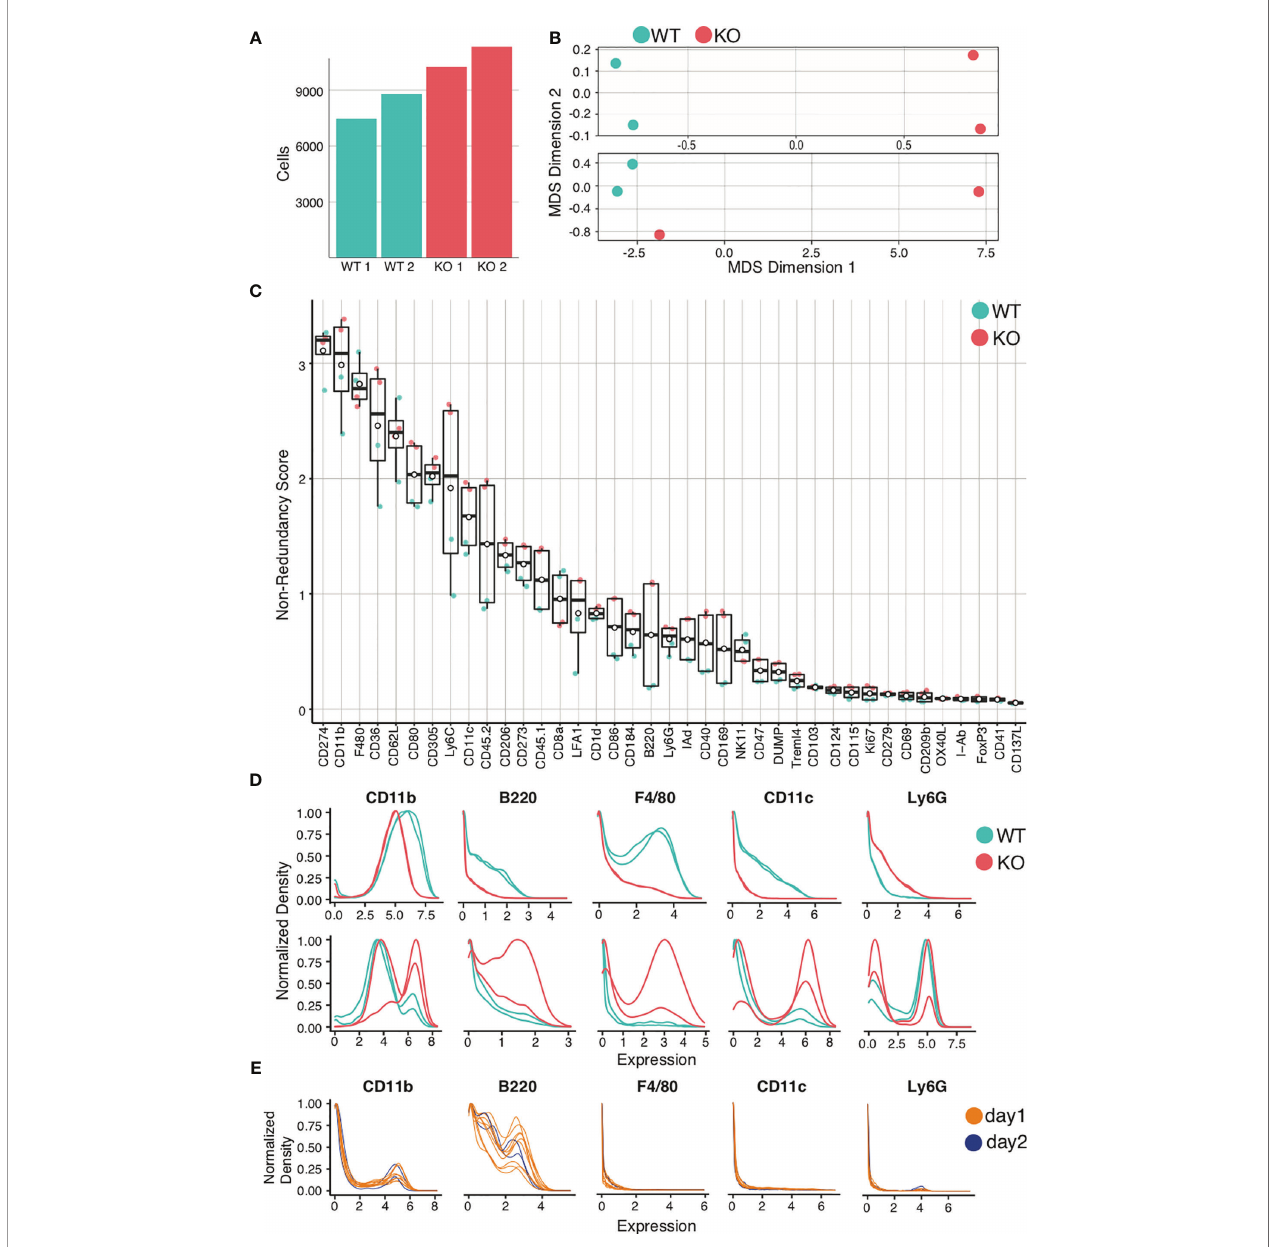
FIGURE 6 | Quality control and marker selection. Mouse bone marrow-derived dendritic cells were generated. Quality control and marker selection was performed on debarcoded/cleaned FCS output after gating to select for live dendritic cell singlets. Figures were generated in R via the CATALYST ® package using their standard settings. (A) Absolute cell number comparisons for a representative analysis using wild-type (WT) and a particular strain of monogenic knockout (KO) mice. (B) Multidimensional Scaling (MDS) plots comparing mass cytometry runs from 2 WT and 2 KO samples are shown (A, C) Non-Redundancy Score (NRS) plot listing the variation between each sample for each marker in the CyTOF panel. (D) Histogram comparing intensity of marker expressions between the samples (Marker Expression Distribution). Due to different sample sizes and distributions, the data was normalized between 0 and 1. (E) Histogram demonstrating the use of spiked-in internal control samples across multiple tubes and data acquisition